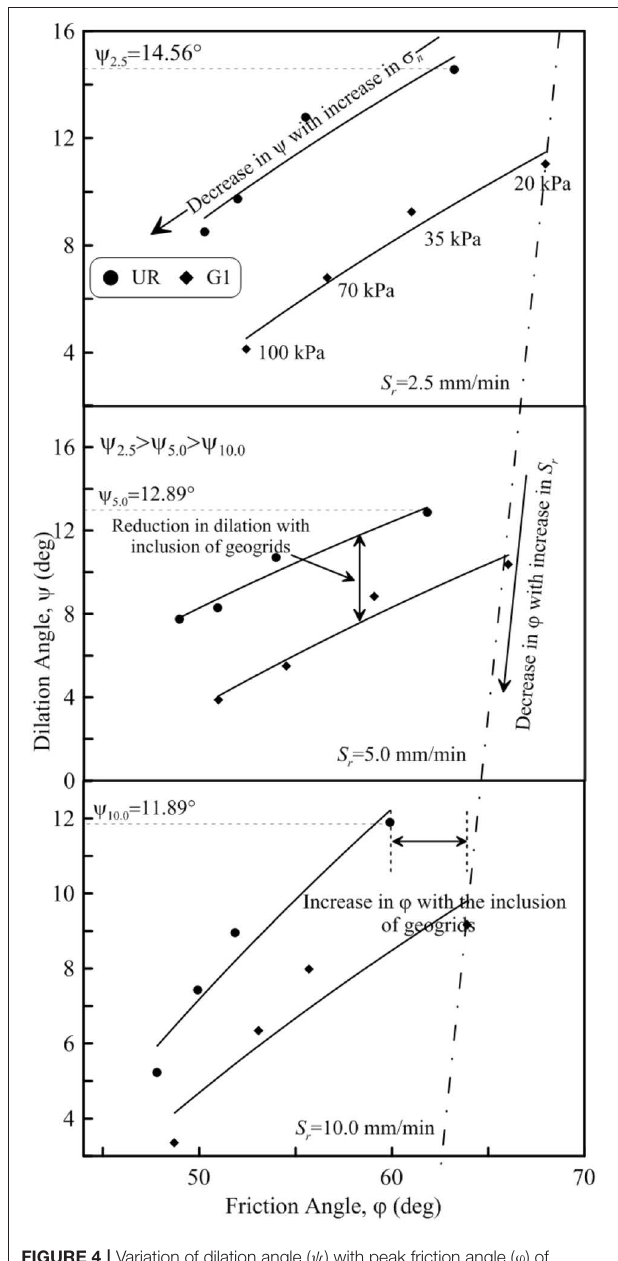
FIGURE 4 | Variation of dilation angle ( ψ ) with peak friction angle ( ϕ ) of unreinforced and geogrid-reinforced ballast-sub-ballast interface.